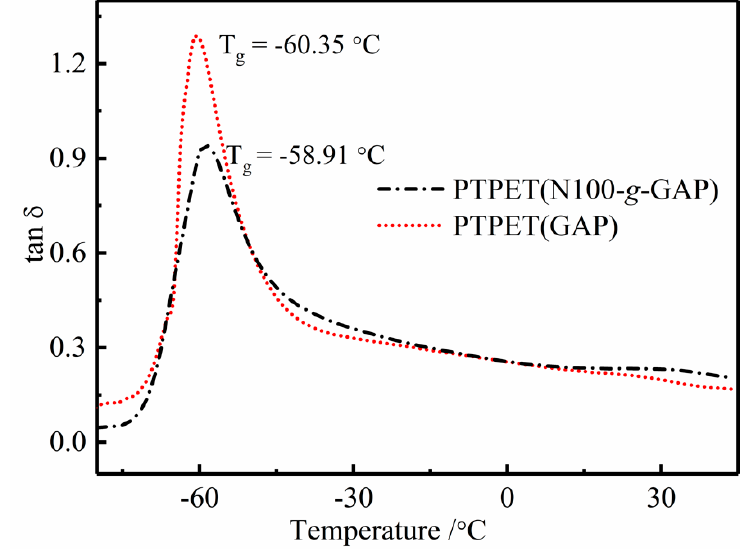
Figure 7. Damping factor of the propellants samples prepared by PTPET (N100- g -GAP) and PTPET (GAP) ( Mn = 4000 g/mol).